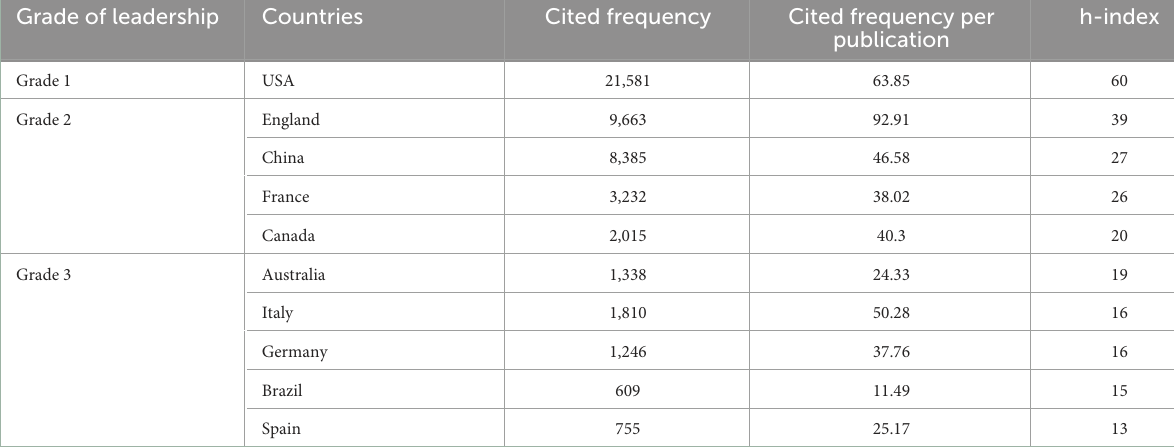
TABLE 4 Top 10 countries with the most leadership.